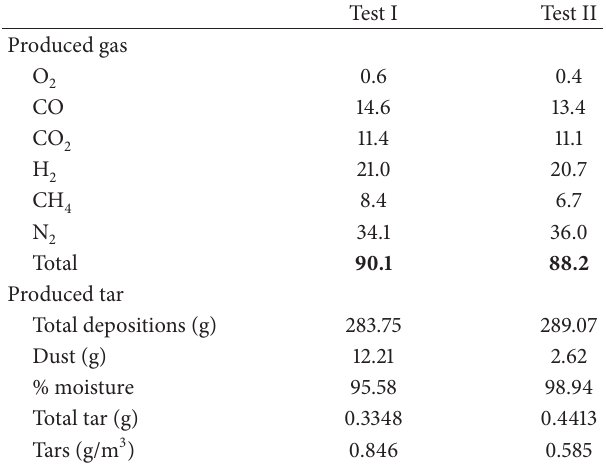
Table 5: Average concentration (%v/v) of O and N in produced gas from tests I and II and tar produced in 2